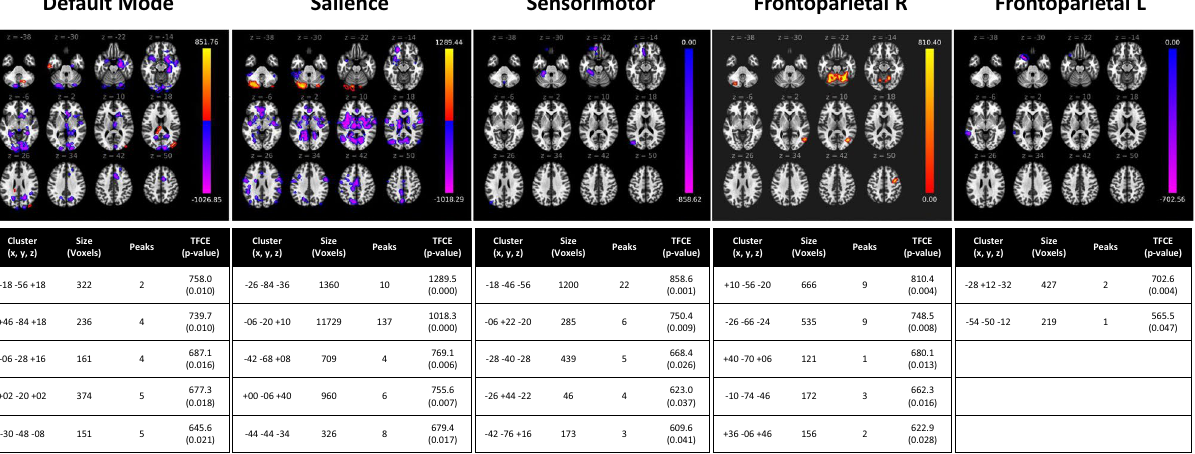
Figure 1. rs-fMRI differences between children with concussion and their healthy peers (mixed-sex cohorts). Clusters (x, y, z) denote standard MNI coordinates at the center of cluster mass, and size represents number of voxels. Up to five clusters with the largest TFCE scores that survived a p-FWE < 0.05 per TFCE are displayed; see Supplemental Table 2 for all clusters that survived